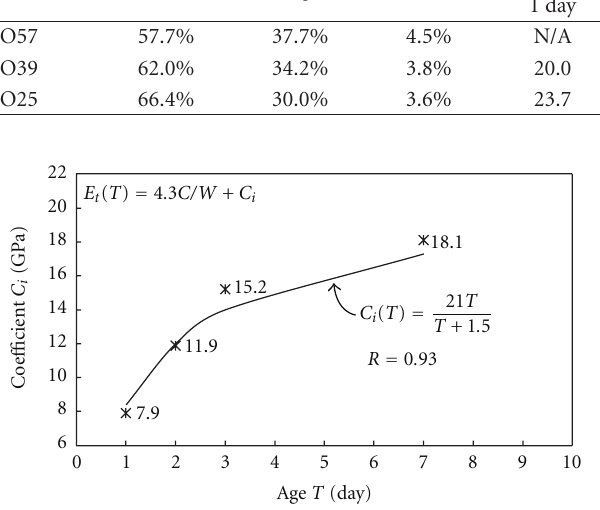
Figure 15: Coe ffi cient C i of the regression line versus age of mortar.